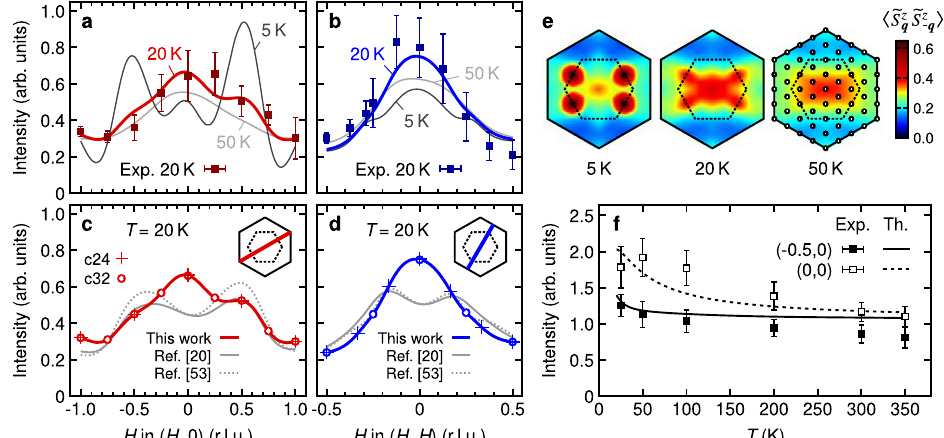
Fig. 5 Theoretical RIXS intensity and pseudospin correlations in the Kitaev – Heisenberg model. a , b Momentum dependence of the theoretical RIXS intensity calculated at T = 5 K (dashed), 20 K (solid blue), and 50 K (solid cyan), using the pseudospin Hamiltonian [Eq. (1)]. To obtain the best fi t to the experimental data (squares), the exchange parameters K = − 5, J = − 3, Γ = 2.5, Γ 0 ¼ 0 : 1 and J 3 = 0.75 meV were used. c , d Comparison of the RIXS intensity computed with different parameter sets. The optimal theoretical curve is compared with those for the parameter sets proposed in refs. 20 and 53 . The insets show the q paths. The points represent results at the accessible q vectors for the 24-site cluster (crosses) and 32-site cluster (circles) that were used to construct the smooth pro fi les. e Temperature evolution of the equal-time pseudospin correlation function h ~ S z q ~ S z (cid:3) q i for the optimal parameter set. The maps were calculated for the 32-site cluster with the accessible q vectors (circles) marked on the 50 K map. f Temperature dependence of the RIXS intensity at q = (0, 0) and ( − 0.5, 0). The data points were collected with the azimuthal angle of ϕ = 0 [the geometry for the ( H , 0) path]. The lines show the theoretical curves obtained by a simulation for the 24-site